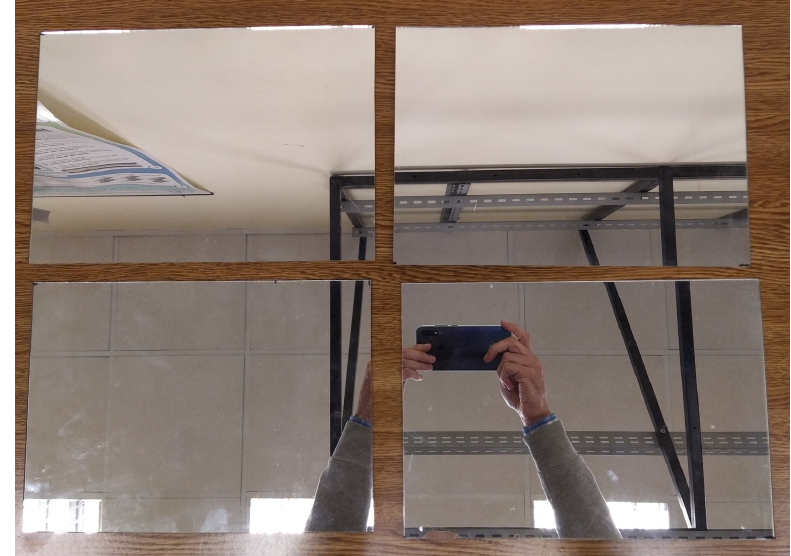
Figure 2. Reflectors used for the